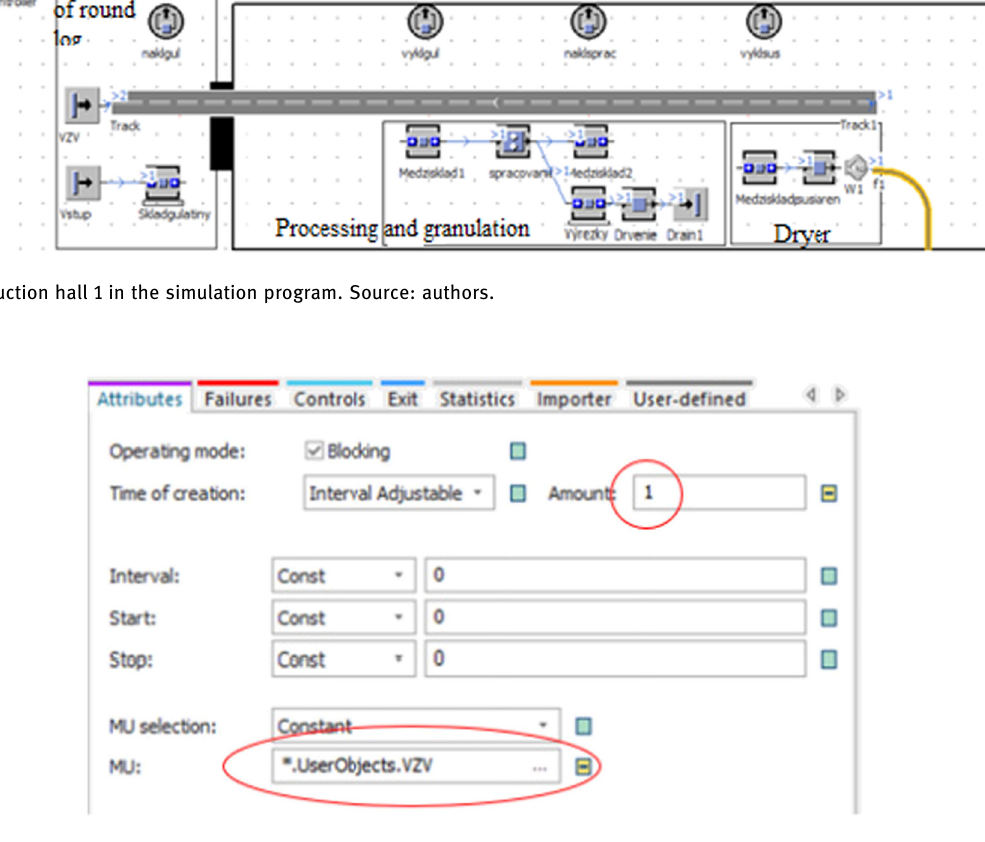
Figure 5: Set up “ Source. ” Source: